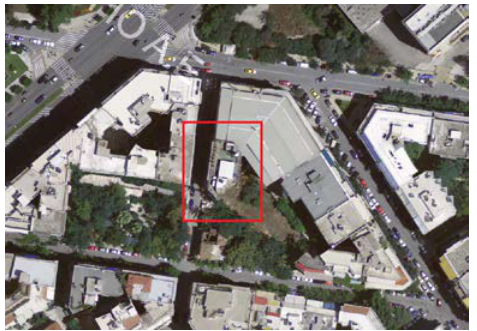
Figure 6. Orthophoto of the case-study area at the scale of 1:1000. The studied building is located within the red rectangle At the second stage, a team that consisted of middle-aged citizens with varied educational background, but with good digital skills, keen with smartphones technology, was chosen.